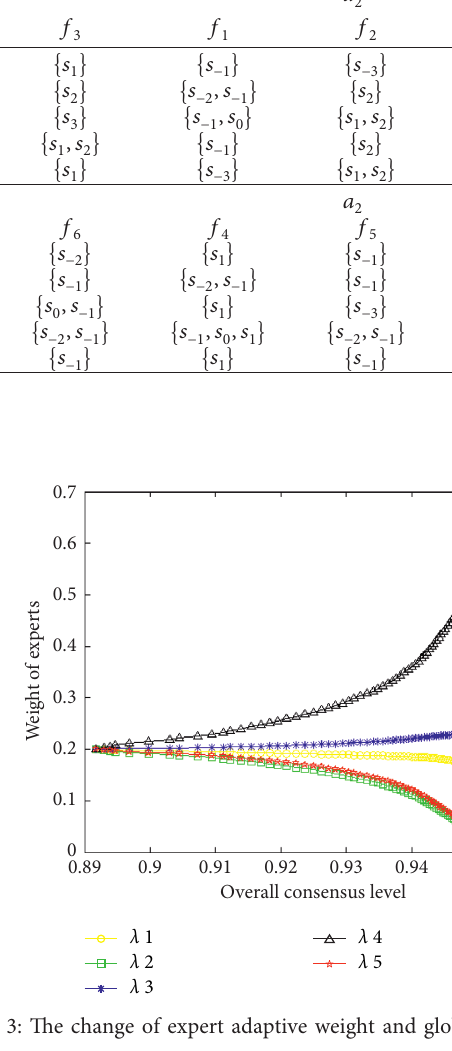
Table 3: Evaluation information of the expert hesitant fuzzy language term set of the talent growth factor index system. a